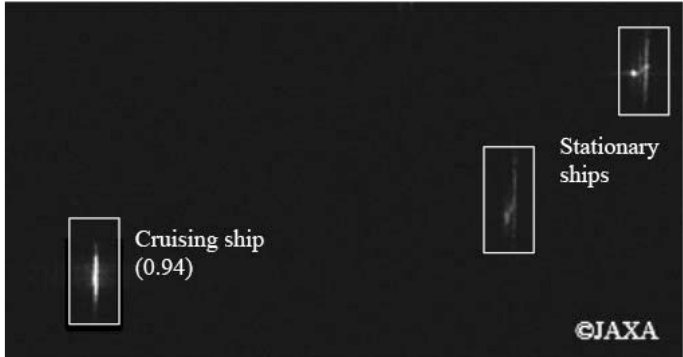
Figure 4. Example of detecting cruising ships and avoiding stationary ships. The left bottom image within the white bounding box is a cruising ship successfully detected with a high confidence score of 0.94. The right two images of ships are defined as stationary.